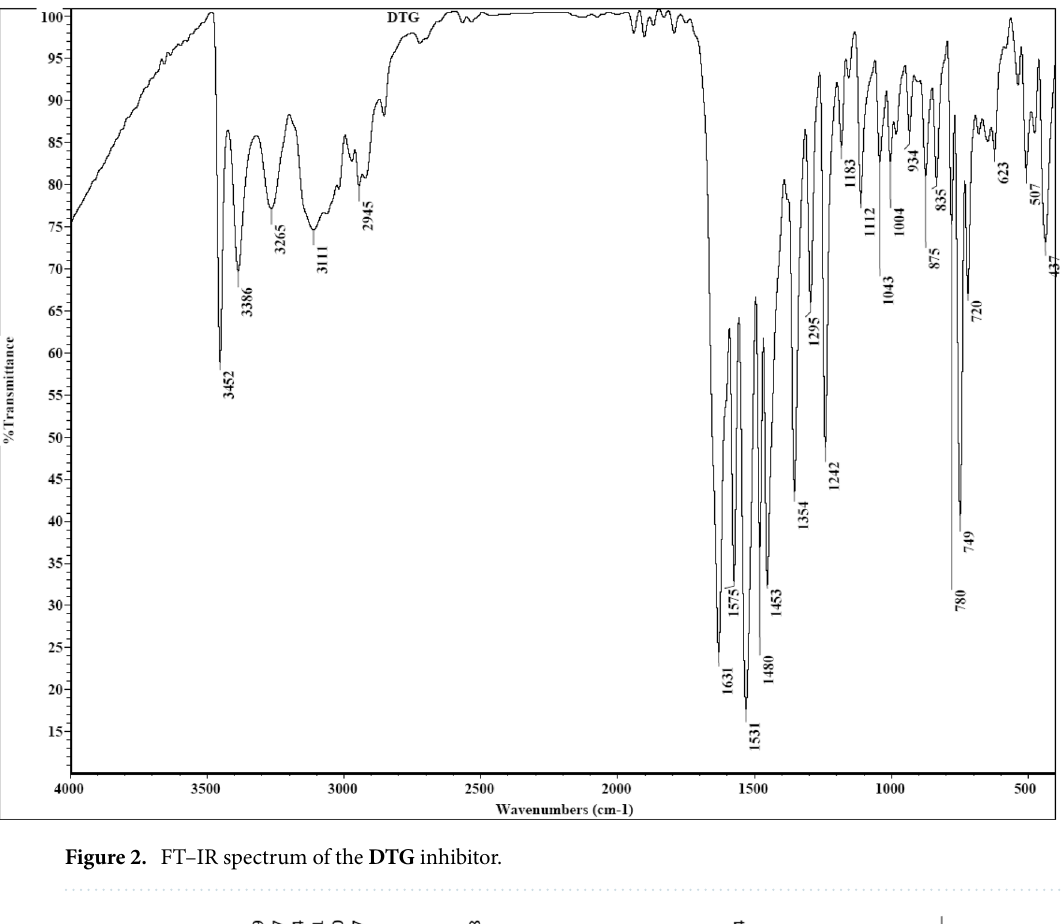
Figure 2. FT–IR spectrum of the DTG inhibitor.